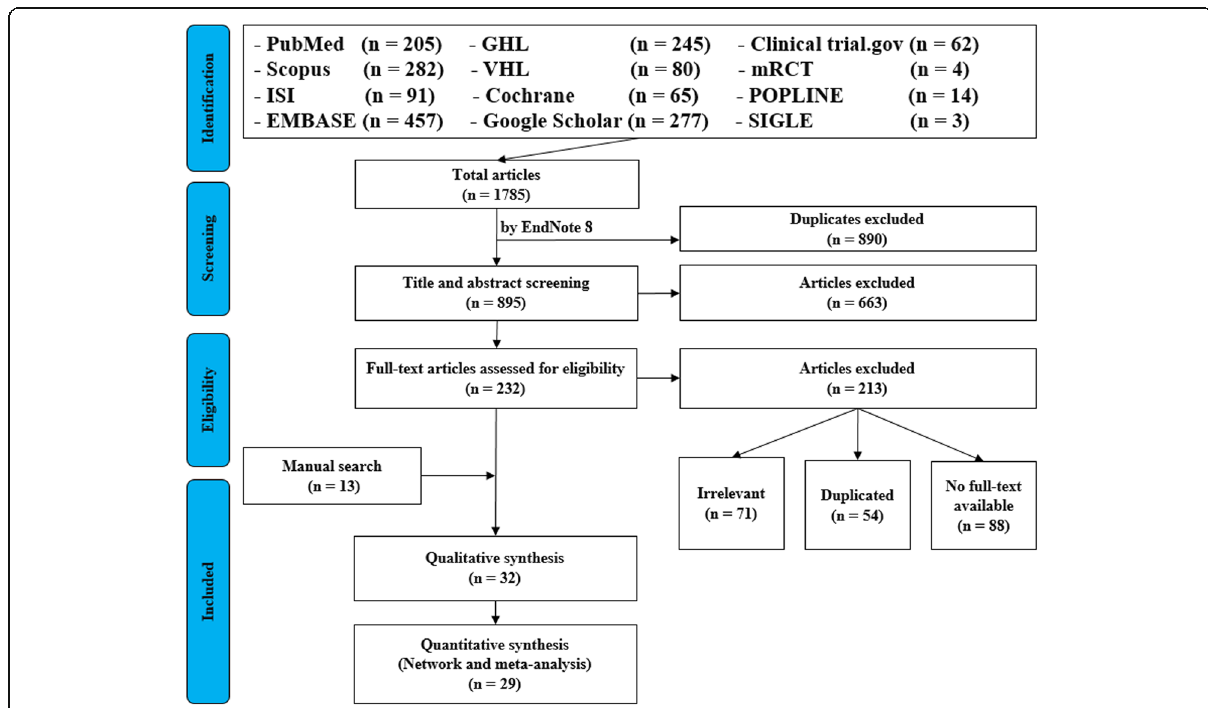
Fig. 2 PRISMA flow diagram of studies ’ screening and